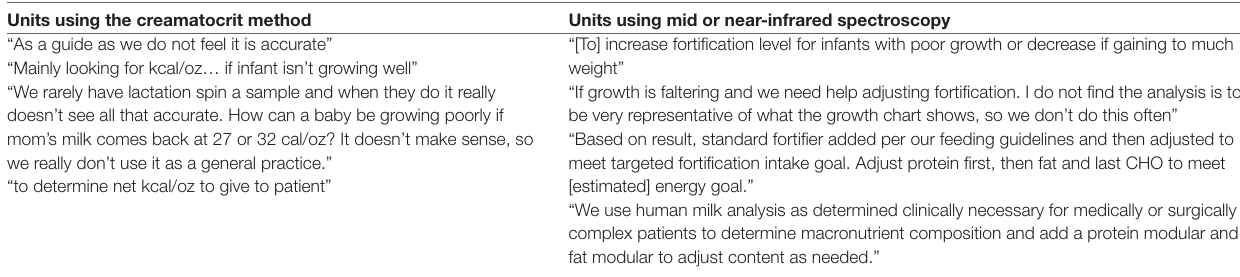
Units using the creamatocrit